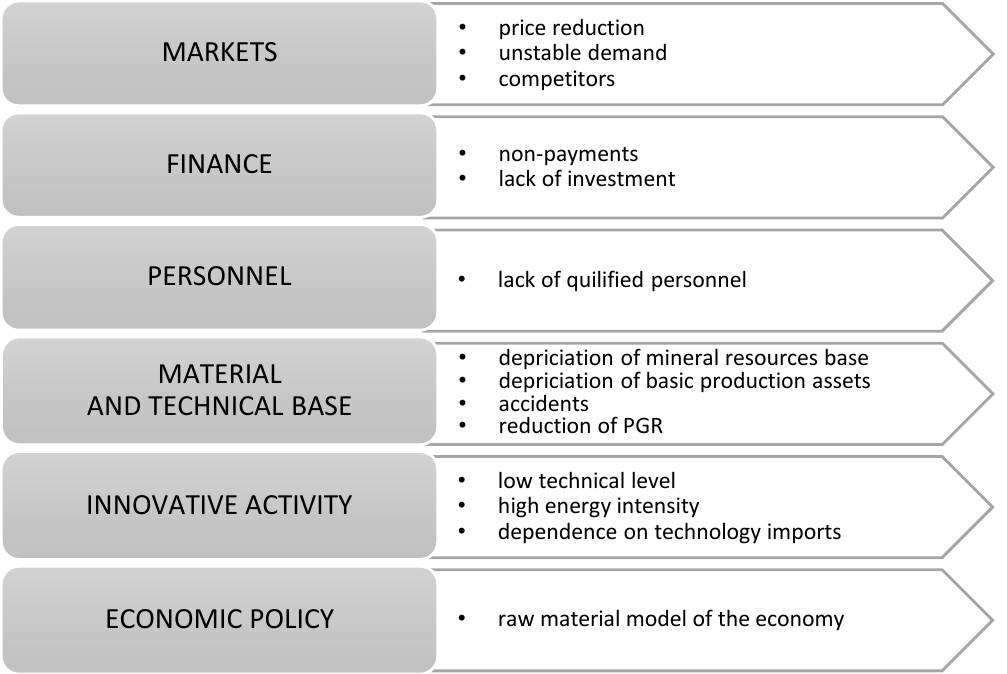
Figure 3. Performance issues of the fuel and energy complex of